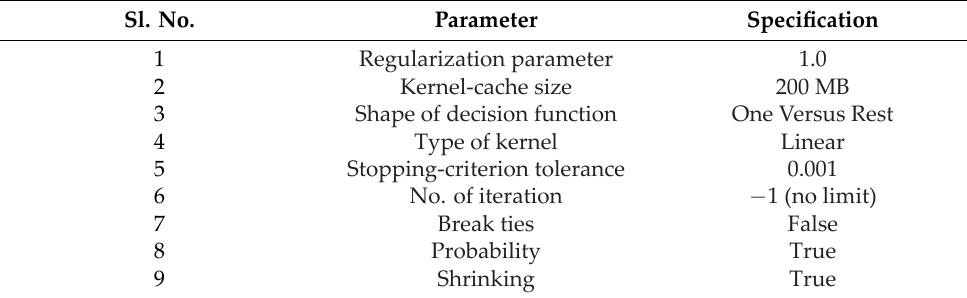
Table 5. Specifications of an SVM classifier as used in the proposed work. Sl.